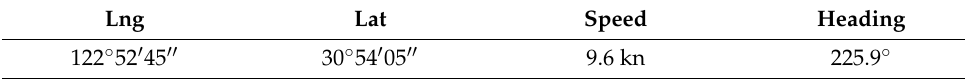
Table 7. Ship’s initial condition.